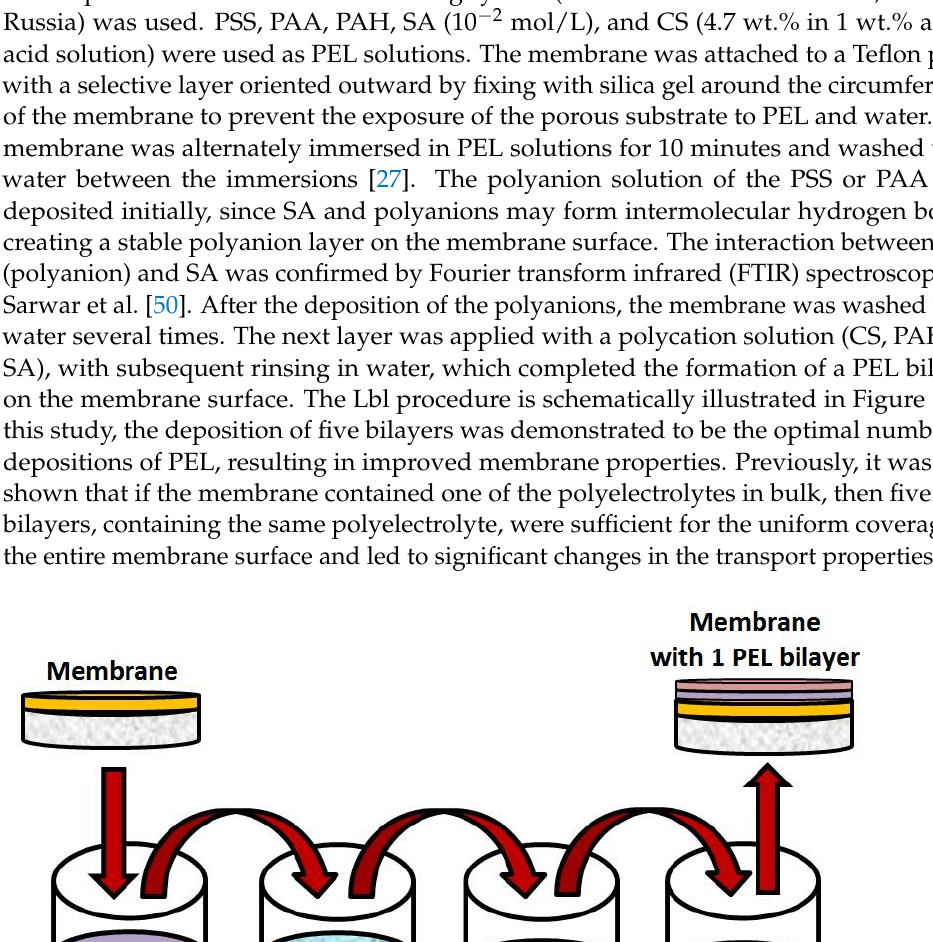
Table 1. Developed supported sodium alginate (SA)-based membranes.